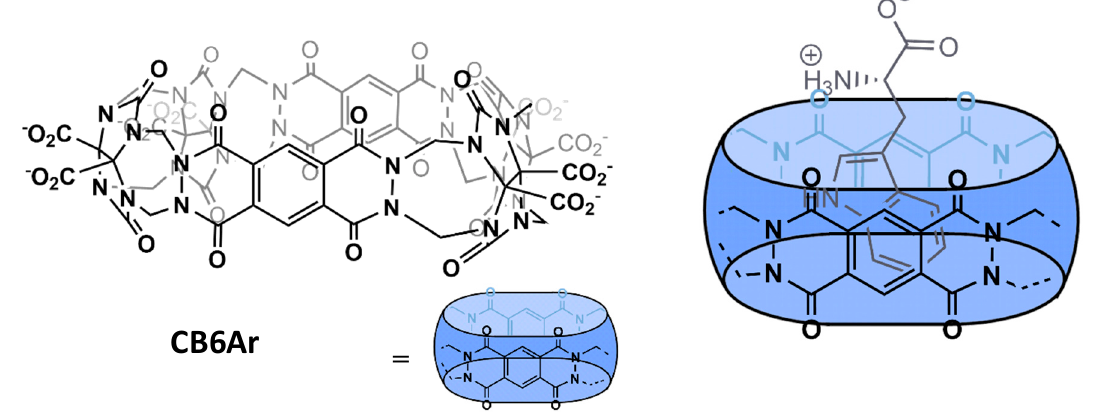
Figure 8. Structure of the modified CB6 receptor, CB6Ar, and a schematization of the complex formed between the receptor and L -Trp, with the establishment of two π – π interactions [40].